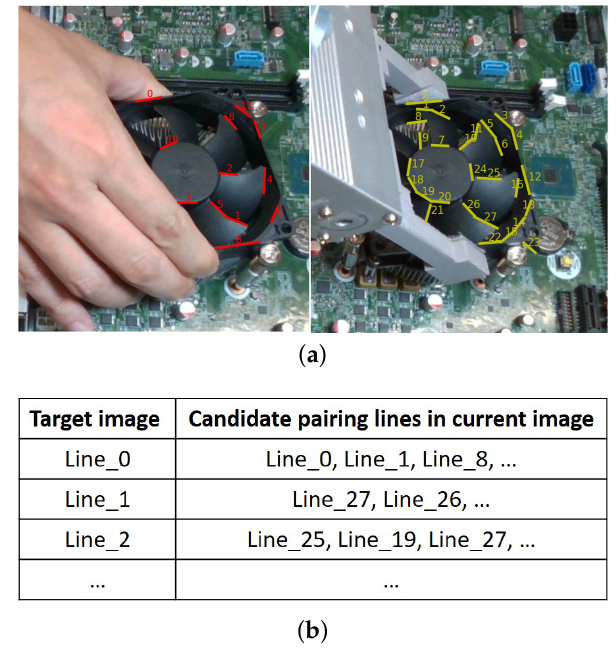
Figure 7. ( a ) Detected line segments in the target image (left) and the current image (right). ( b ) Initial paired line segments between target and current images. Initial line pairs based on the angle and distance